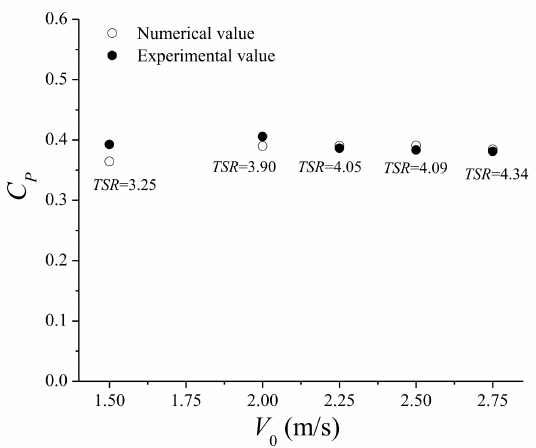
Figure 8. Computational model validation with experimental data at different values of current velocity and TSR